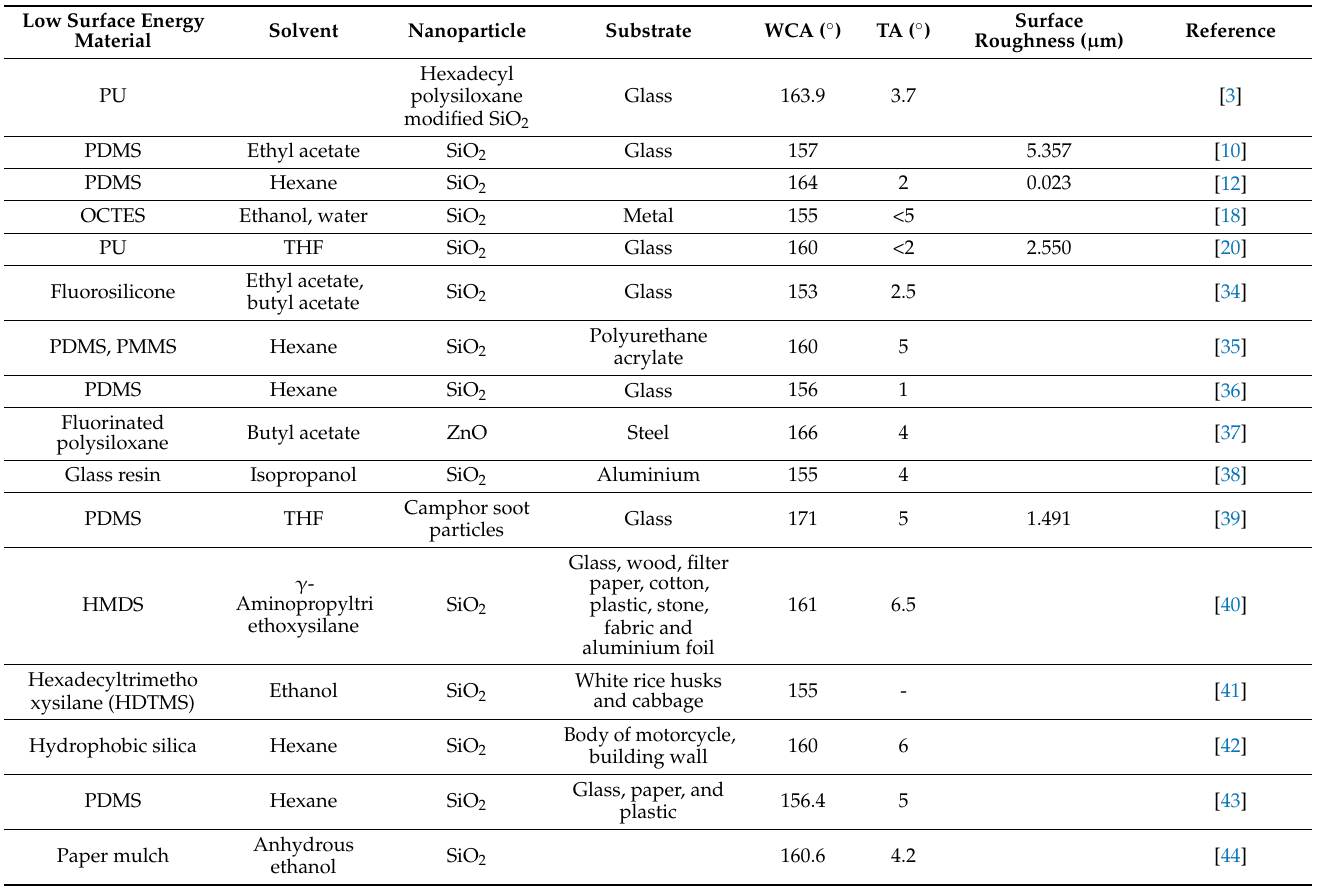
Table 1. Main precursors for spray-coating fabrication method with their respective water contact angle, titling angle and surface